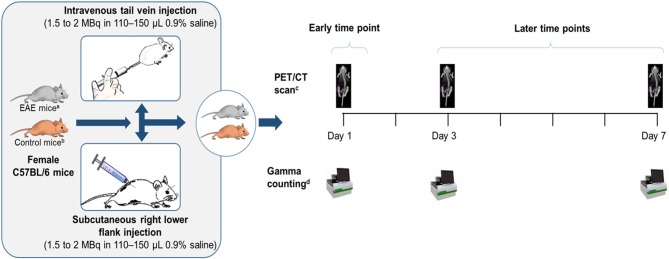
Study design. aC57BL/6 mice post-EAE induction who had reached the peak of the disease on Days 14–15. bControl mice were sham-injected (i.e., subjected to the same procedure as EAE-induced mice, except that rhMOG was replaced with saline). cWhole body clearance and biodistribution of the tracer were assessed by PET/CT imaging. dOrgans excised from a subset of mice (n = 7–9) and assessed for biodistribution of the tracer by gamma counting. EAE, experimental autoimmune encephalomyelitis; MBq, megaBecquerel; n, number of mice; PET/CT, positron emission tomography/computed tomography; rhMOG, recombinant human myelin oligodendrocyte glycoprotein.